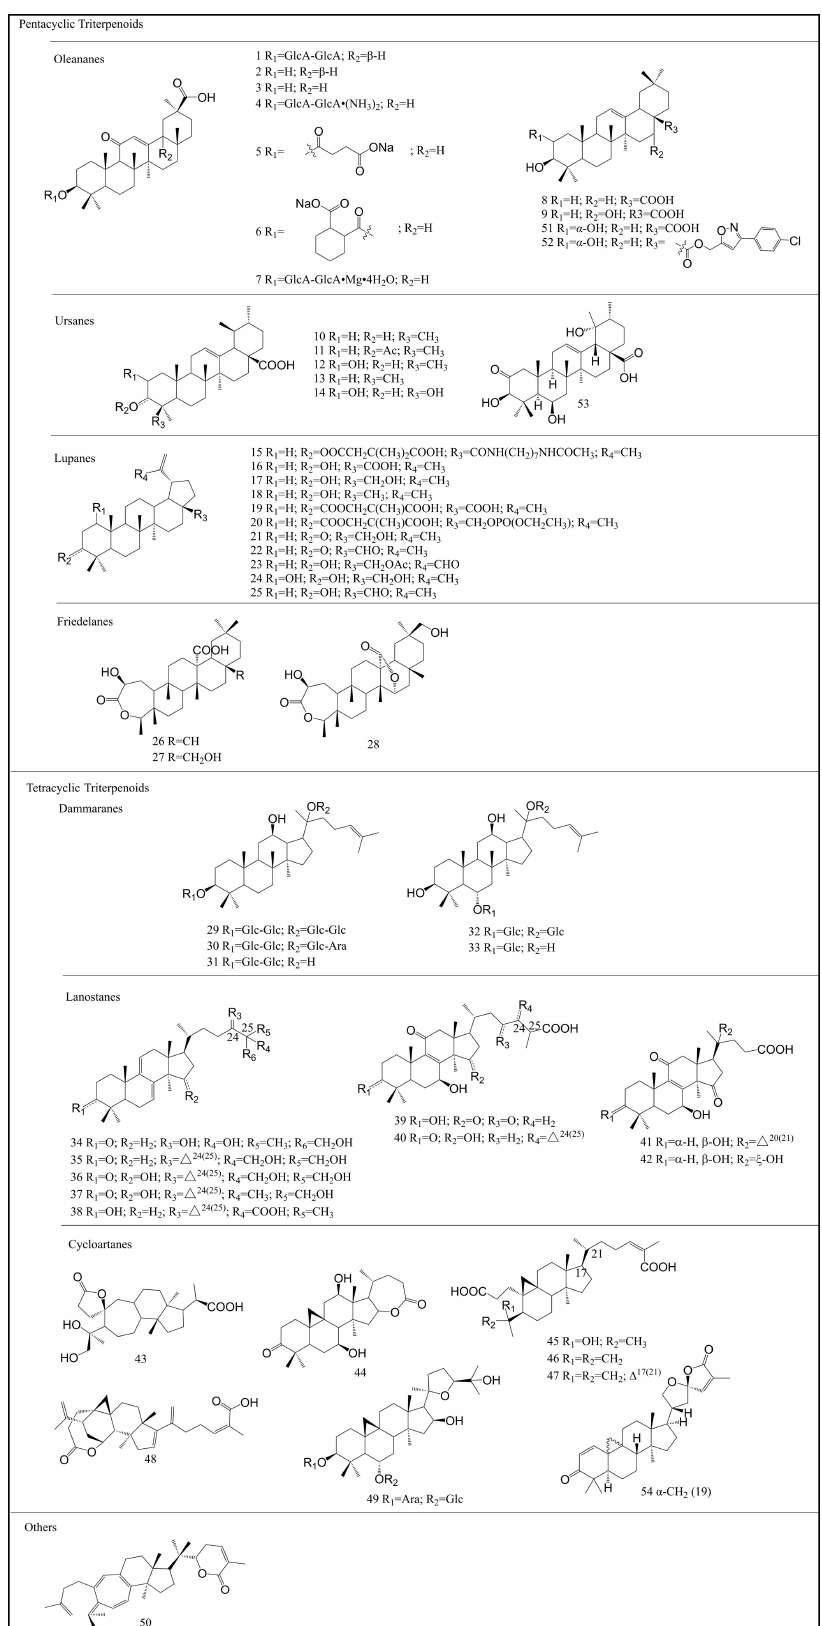
Figure 2. Different types of triterpenoids with antiviral